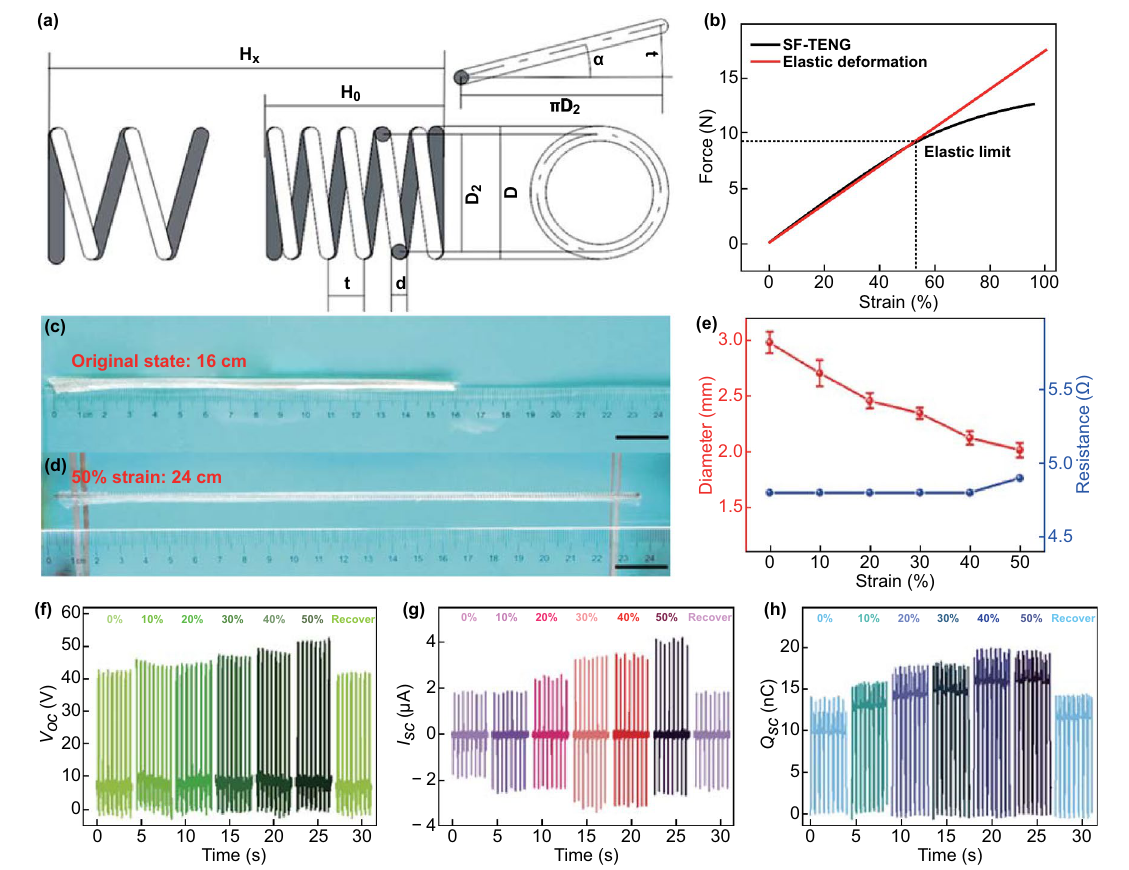
Fig. 3 Output performance of the FST–TENG under different strain level. a Geometrical diagram of stretching spiral steel wire and b stress– strain curve of FST–TENG. The photograph of the spiral steel wire‑based TENG c at original state and d stretched state (scale bar: 2 cm). e Dependence of the resistance and diameter of the spiral steel wire‑based TENG under different strain levels (0–50%). Electrical output of the FST–TENG under various strain levels including f V oc , g I sc , and h Q